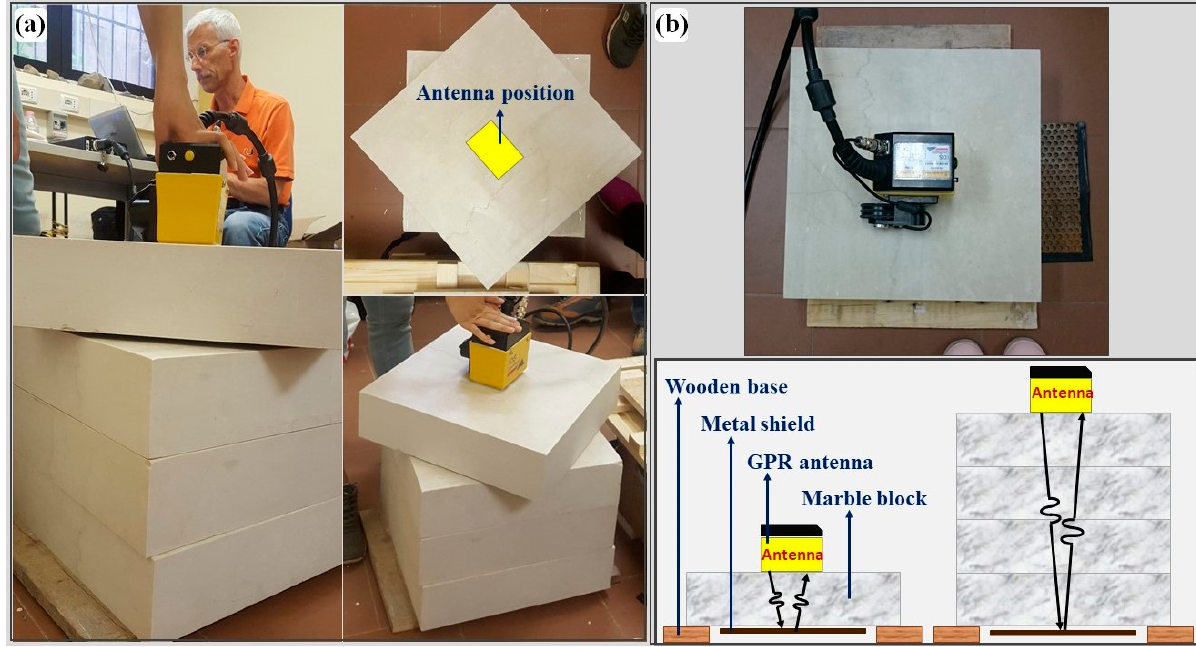
Figure 4. ( a ) GPR measurements in the center of marble blocks with the fracture aperture that was gradually increased from 0.25 mm to 16 mm. ( b ) Tests using a metal shield to estimate the